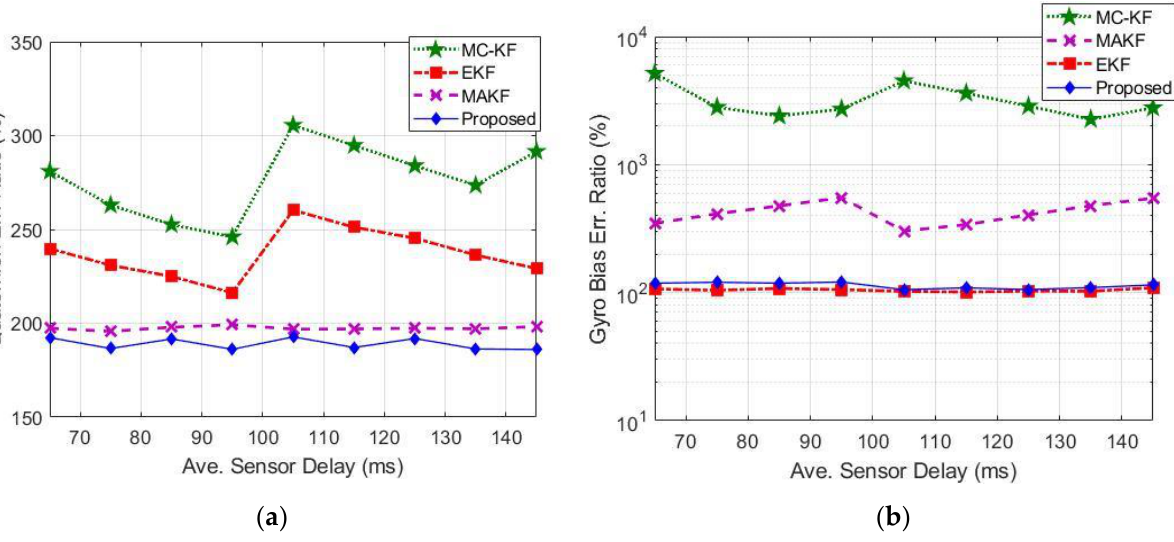
Figure 6. Estimation accuracy performance comparison with respect to zero-sensor delay scenario: ( a ) Magnitude of quaternion error, and ( b ) Magnitude of gyro bias error.